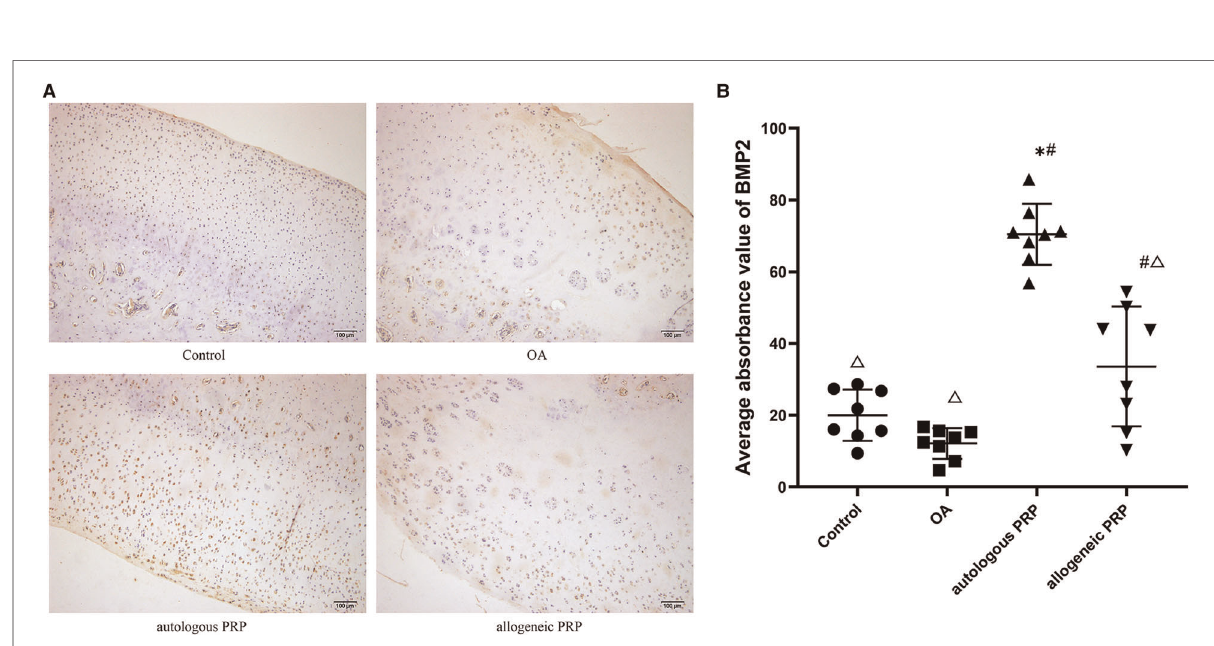
FIGURE 2 ( AB ) Immunohistochemical analysis of BMP-2 in joint fl uid. Scale bar 100 µm. All groups ( n =8). Signi fi cant differences, if any, were indicated as * p <0.05 compared control, # p <0.05 compared to OA, and ? P <0.05 compared to autologous PRP.BMP-2, bone morphogeneic protein; OA, osteoarthritis; PRP, platelet-rich